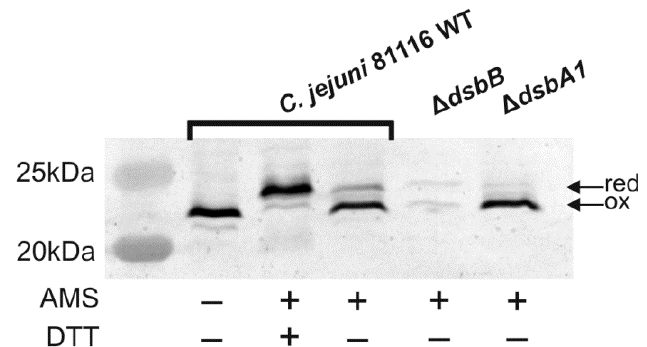
Figure 2. CjDsbA2 was present mainly in oxidized form in wild-type and ∆ cjdsbA1 C. jejuni 81116 cells, whereas lack of CjDsbB resulted in almost undetectable levels of CjDsbA2. Bacterial cell cultures were treated with 10% TCA (trichloroacetic acid) and AMS (4-acetamido-4 (cid:48) -maleimidylstilbene-2,2 (cid:48) -disulfonic acid). The controls were reduced (red; treated with DTT and AMS) and oxidized (ox; untreated with AMS) wild-type cellular proteins. Samples were electrophoretically separated under non-reducing conditions using 16% polyacrylamide gels with sucrose addition. Then, Western blot analyses using specific anti-CjDsbA2 serum were performed. Three independent experiments were performed ( n = 3). The figure presents a representative result.